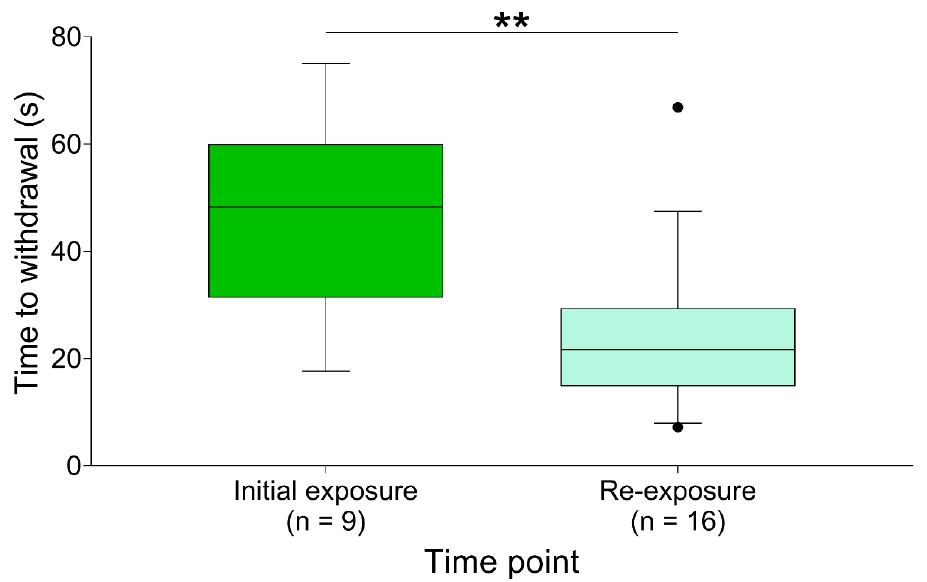
Figure 4. Time to withdrawal pooled by timepoint (initial and re-exposure). Rats withdrew faster upon re-exposure ( p < 0.01). Sample sizes reflect animals that withdrew. ** p < 0.01. Data are presented as median (middle line in box), IQR (box limits) and 10–90 percentile (whiskers). Solid circles indicate outliers (values lying ± 1.5 ×